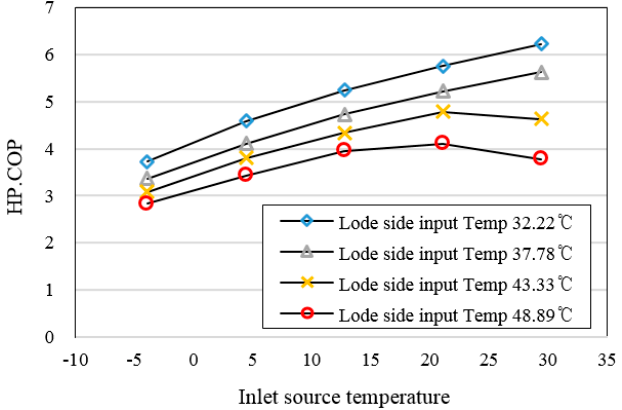
Figure 6. Heating catalog data of heat pump.